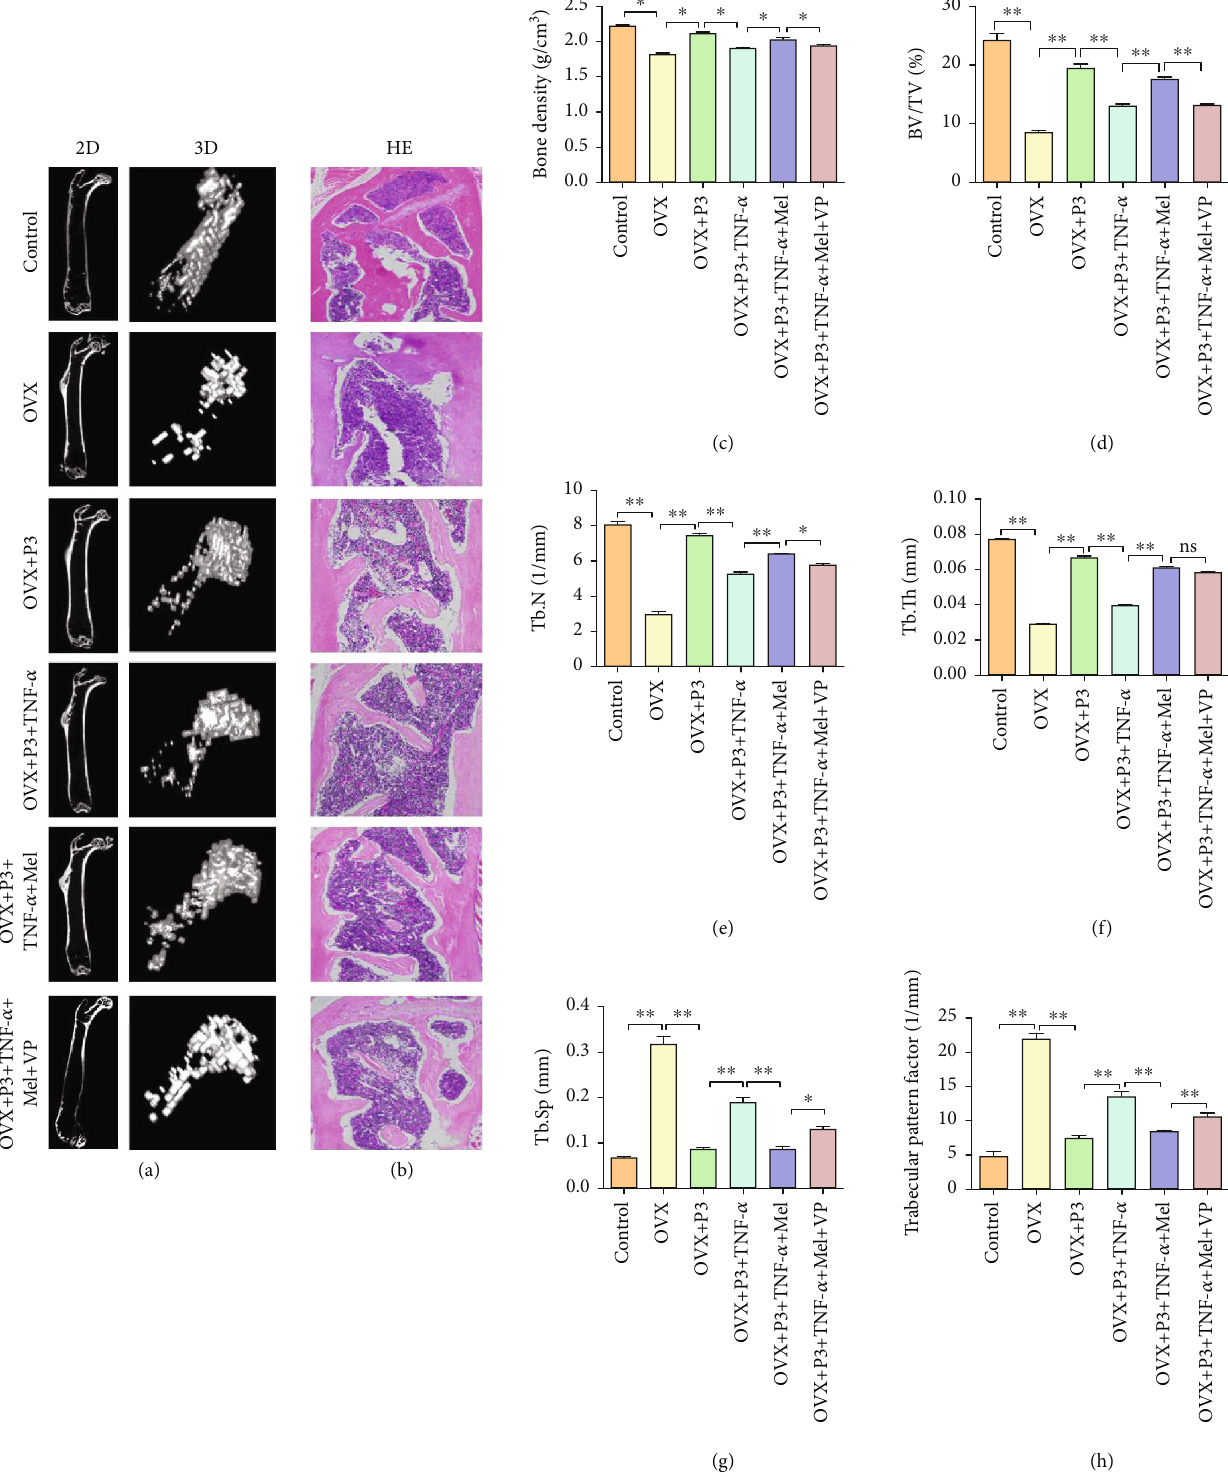
Figure 5: Stem cell treatment of osteoporosis mouse model. (a) Micro-CT examination of a two-dimensional and three-dimensional map of trabecular bone in di ff erent groups. (b) H&E staining of the proximal femur of mice in di ff erent groups. (c) Bone density analysis of osteoporosis mouse with di ff erent treatments. (d) Bone volume density (BV/TV) of osteoporosis mouse with di ff erent treatments. (e) Trabecular number (Tb.N) of osteoporosis mouse with di ff erent treatments. (f) Trabecular thickness (Tb.Th) of osteoporosis mouse with di ff erent treatments. (g) Trabecular separation (Tb.Sp) of osteoporosis mouse with di ff erent treatments. (h) Trabecular pattern factor of osteoporosis mouse with di ff erent treatments. Ten nude mice were included in each group. ∗ P < 0 : 05 ; ∗∗ P < 0 : 01